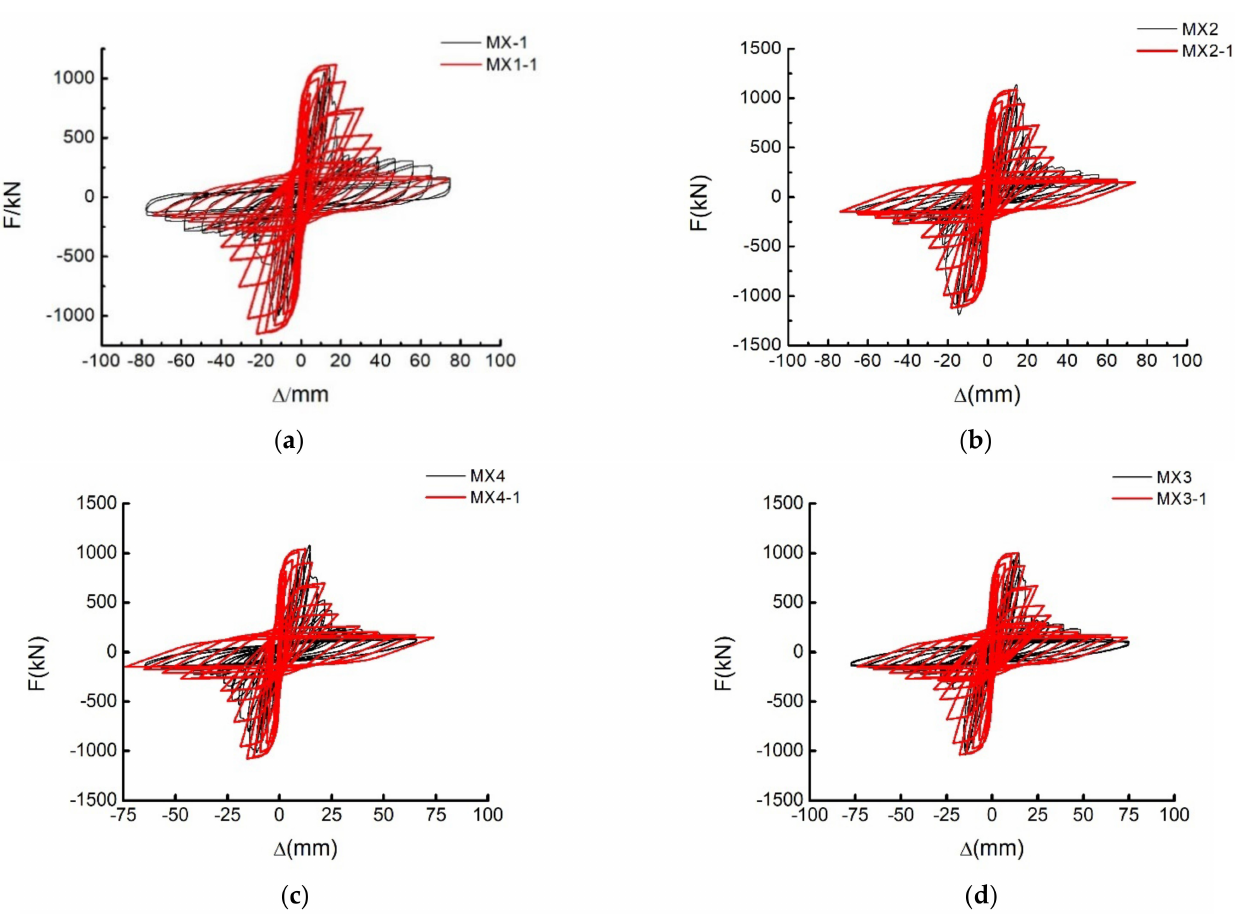
Figure 5. Comparison between hysteretic curves obtained from simulations and experimental